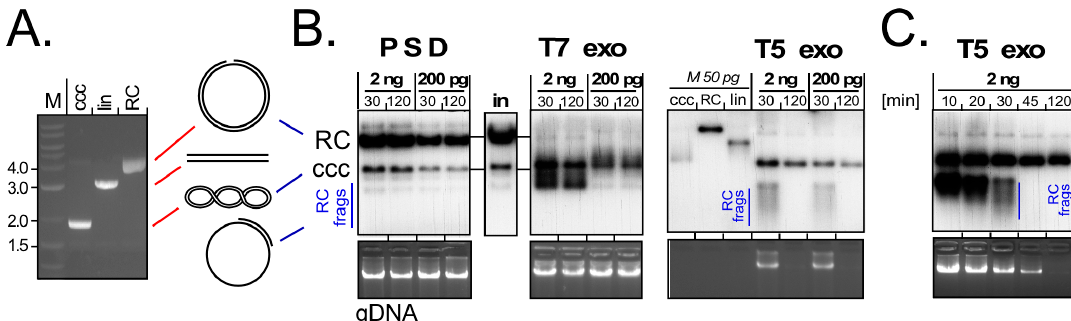
Figure 4. A detour to the bench—suitability of different exonucleases for selective degradation of non-cccDNA forms. ( A ) Model substrates. A 3.2 kb plasmid carrying 800 bp of HBV sequence (lane ccc) was linearized (lane lin) with Bsp QI or nicked (lane RC) with nickase Nt.Bsp QI (both NEB); ( B ) Differential sensitivity towards Plasmid-Safe DNase (PSD) and T7 and T5 exonuclease (T7exo, T5exo). Plasmid RC-DNA and cccDNA were mixed to contain per 50 µL reaction 2 ng or 200 pg of each plasmid DNA plus 4 µg genomic DNA (gDNA) from Huh7 cells (equivalent to 0.6 × 10 6 cells). supplemented with 10 U of PSD (Epicentre; 1× Plasmid-Safe reaction buffer with 1 mM ATP), or T7